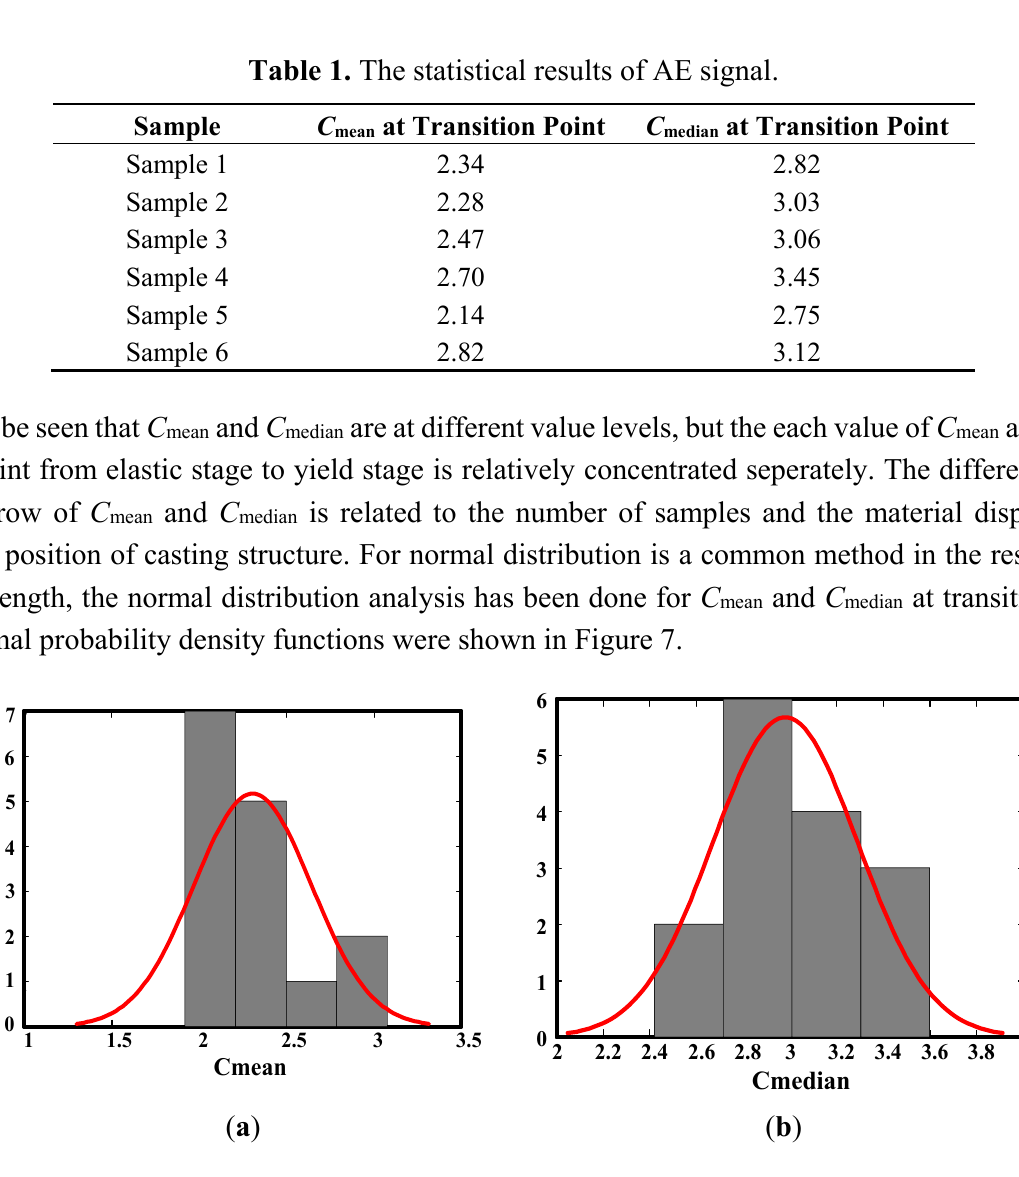
Figure 7. Histogram and normal distribution analysis of C mean and C median at the transition point. ( a ) Histogram and normal distribution analysis of C mean ; ( b ) Histogram and normal distribution analysis of C median